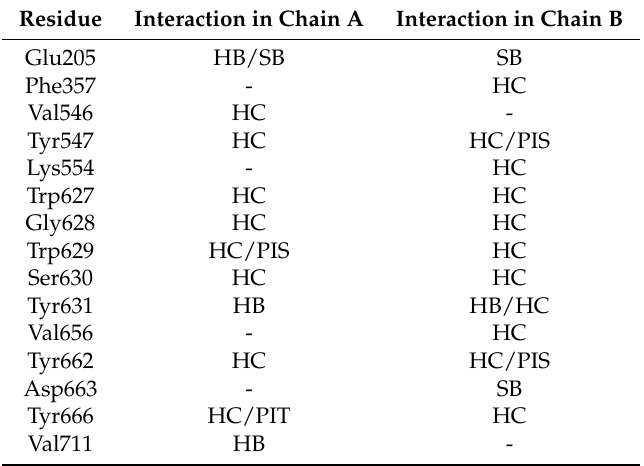
Table 1. Molecular interactions detected by BINANA for the N7F inhibitor at DPP-4 (PDB code: 4A5S). Residue Interaction in Chain A Interaction in Chain B Glu205 HB/SB SB Phe357